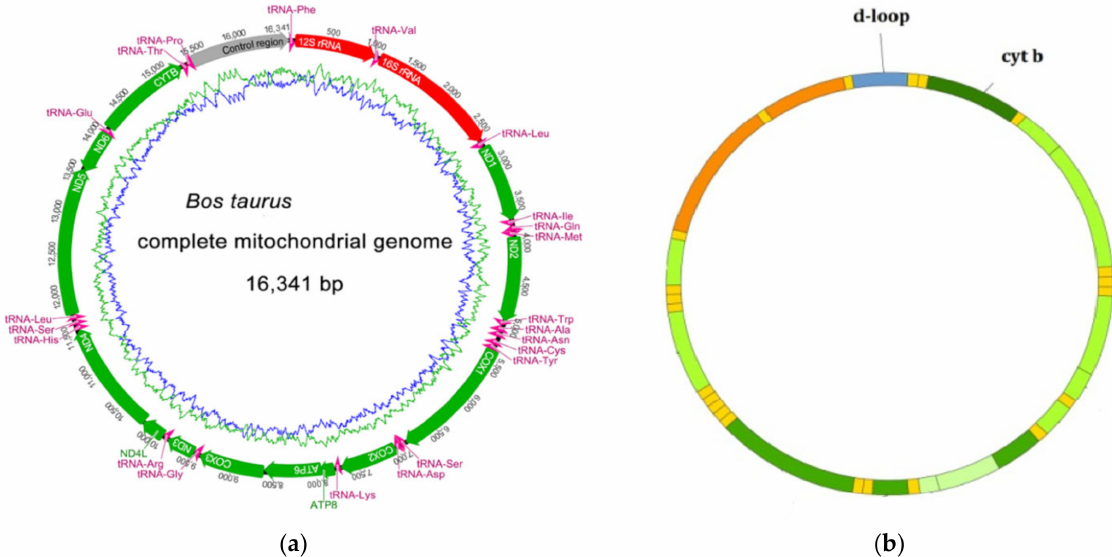
Figure 2. The complete mitochondrial genome of Bos taurus : ( a ) complete mitochondrial genome of Bos taurus (16,340 bp); ( b ) mitochondrial markers analyzed—cytochrome b (1140 bp) and d-loop- (910 bp) [29]. Table 3. PCR program: cytochrome b and d-loop sequence amplification. Stages